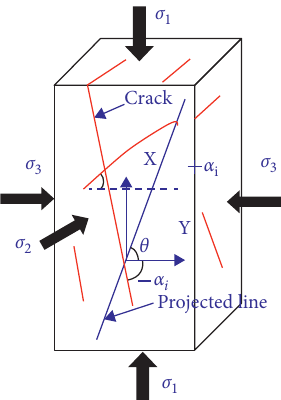
Figure 1: Schematic view of statistical method for evaluating the natural cracks’ geometric characteristics of rock